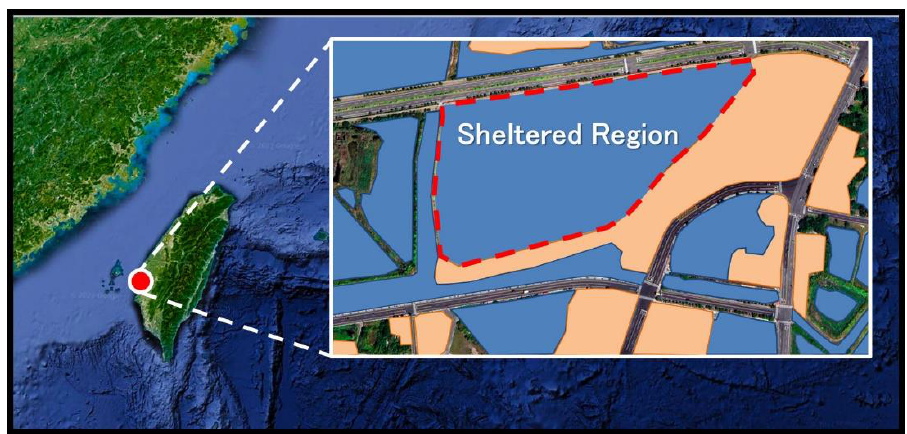
Figure 1. Area for wind protection at Budai Port in Taiwan.